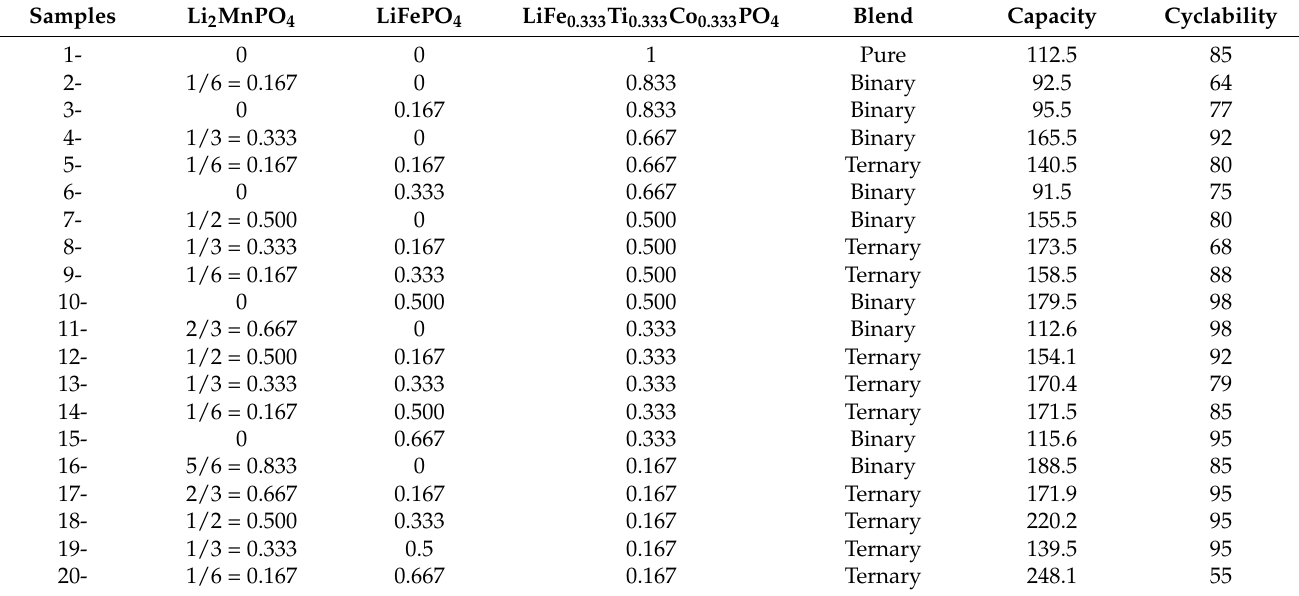
Table 4. Summary capacity and cyclability for 28 samples for the system